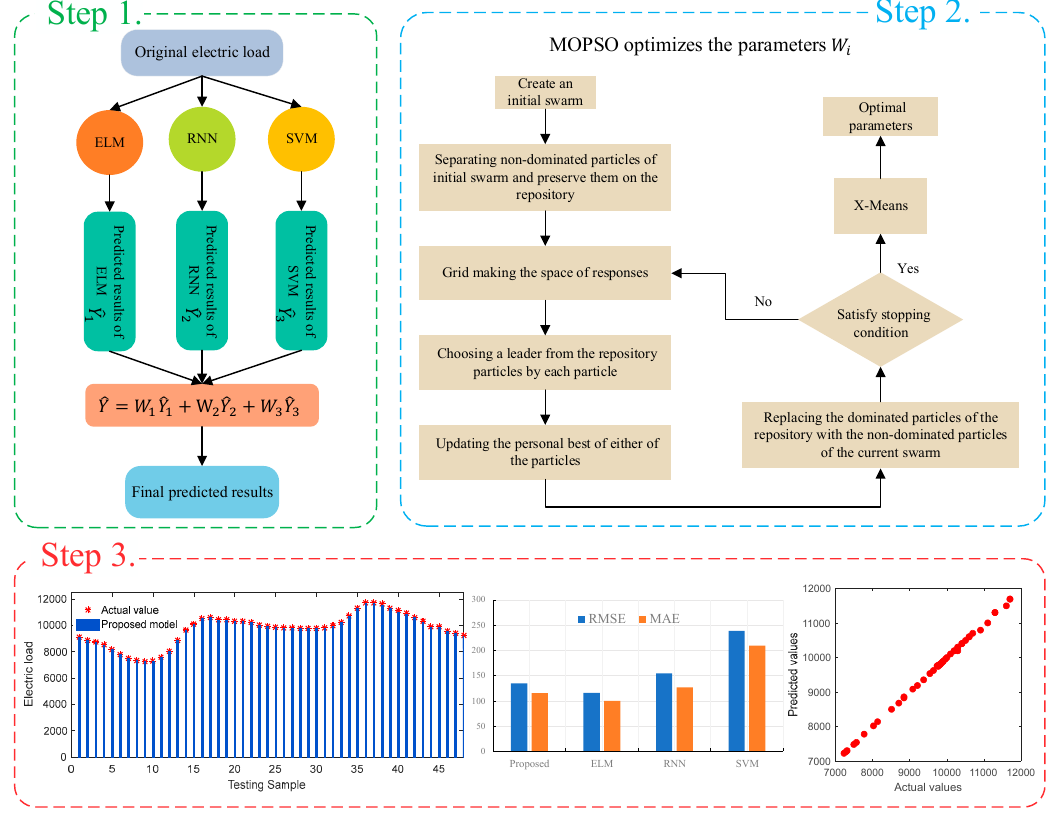
Figure 2. The flowchart of the proposed model. Step 1. Three ANNs, which include ELM, RNN, and SVM, are applied separately to forecast the electric load. After that, combined theory [10] is used to combine the three intermediate forecasting